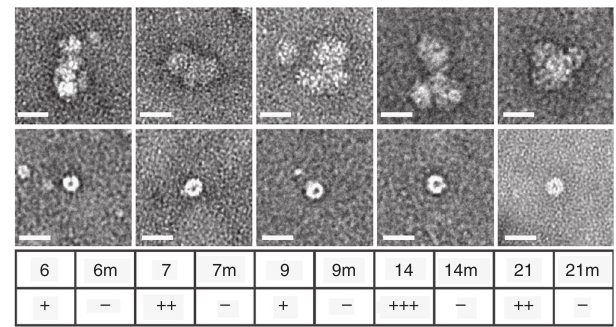
Fig. 4 In vitro pentamer binding to the predicted PSs. In vitro analysis of PS: pentamer interactions by MST, HPeV1 pentamers were titrated into fi xed amounts of 5 ʹ -Alexa 488-labelled short RNAs encompassing PSs 6,